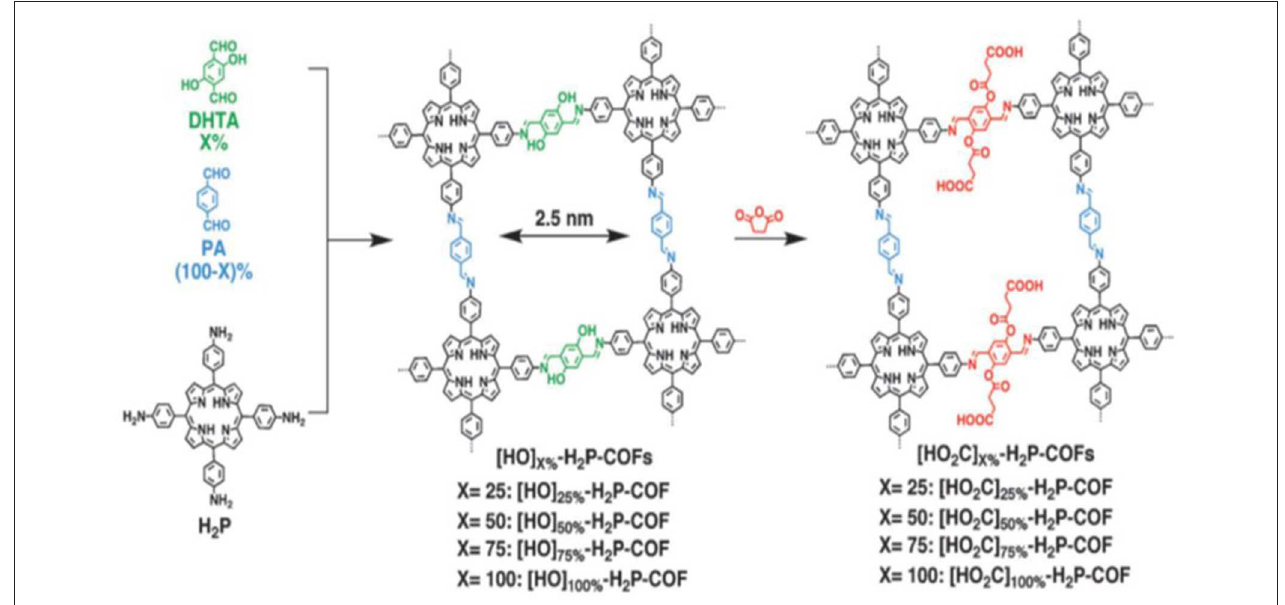
FIGURE 7 | Structure of [HO 2 C] x % -H 2 P = COFs synthesized by Huang et al. Reprinted with Permission © 2015 Wiley